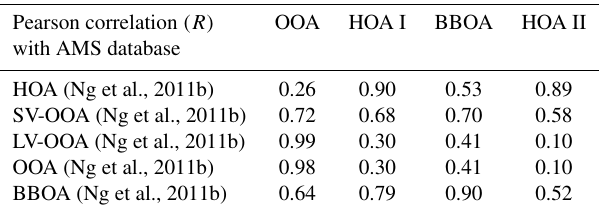
Figure 3. PMF mass spectra of the four PMF solutions con- taining oxygenated organic aerosol (OOA), biomass burning or- ganic aerosols (BBOA) and two hydrocarbon-like organic aerosols (HOA I and HOA II ). Table 3. Pearson correlation coefficients (R) between mass spectra of OA PMF factors and AMS database (http://cires1.colorado.edu/ jimenez-group/AMSsd/, last access: 7 June 2021).